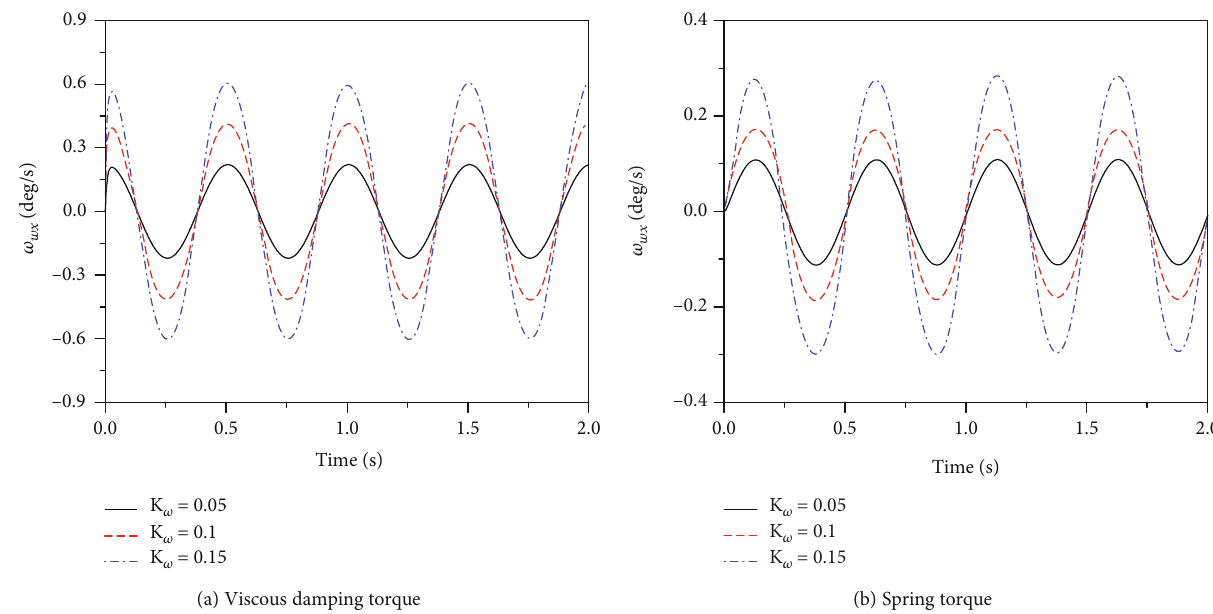
Figure 5: DRR of the roll interference